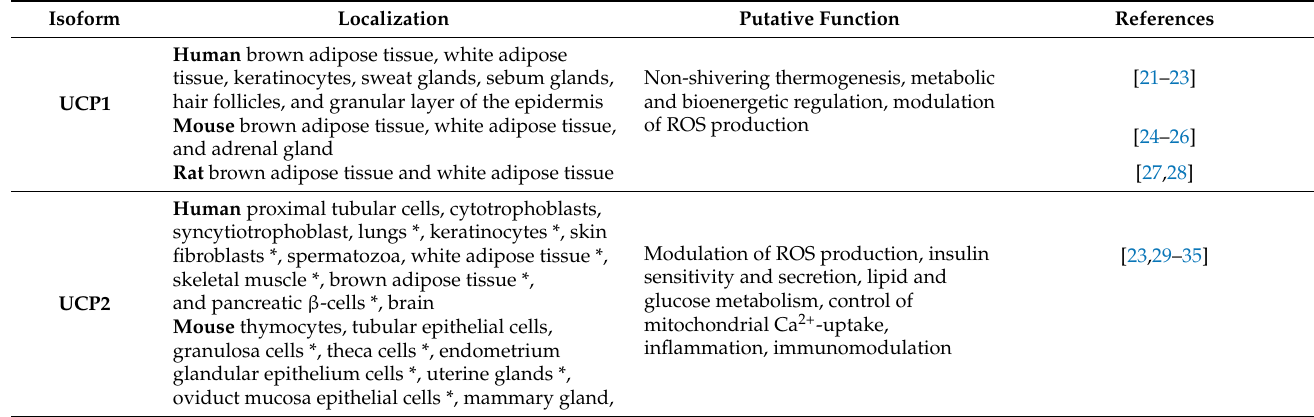
Table 1. Expression and hypothesized functions of all mitochondrial uncoupling proteins (UCPs) homologs.